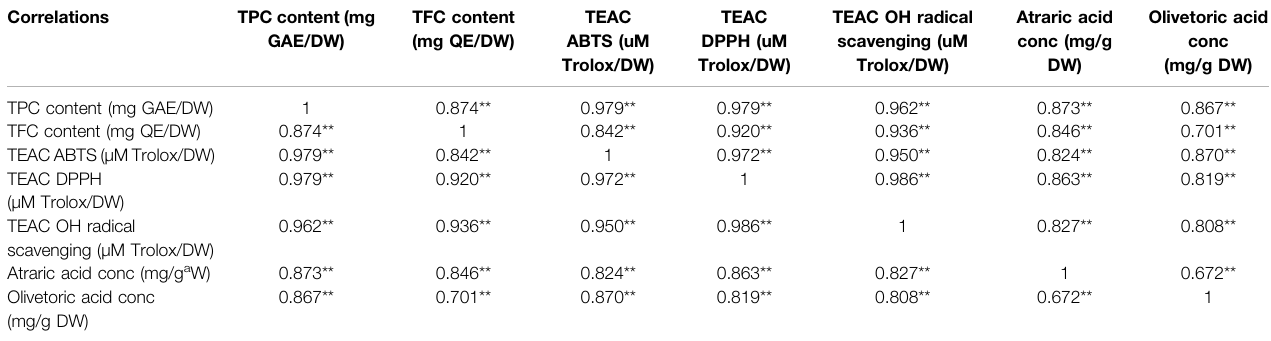
TABLE 2 | Values of Pearson ’ s correlation coef fi cients (r) for the TPC, TFC, TEAC (DPPH), TEAC (ABTS), TEAC (OH radical scavenging), Atraric acid and Olivetoric acid concentration. Correlations